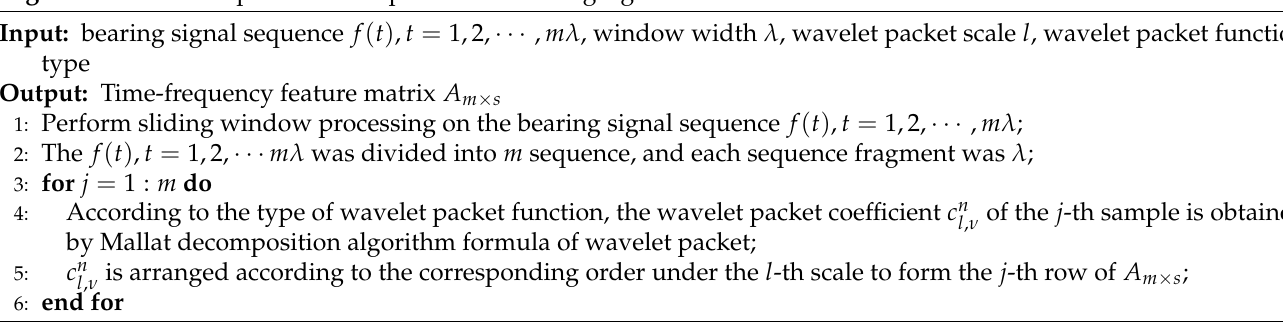
Figure 2. Schematic diagram of the wavelet packet structure decomposition at scale l = 3. Algorithm 1 Wavelet packet decomposition of bearing